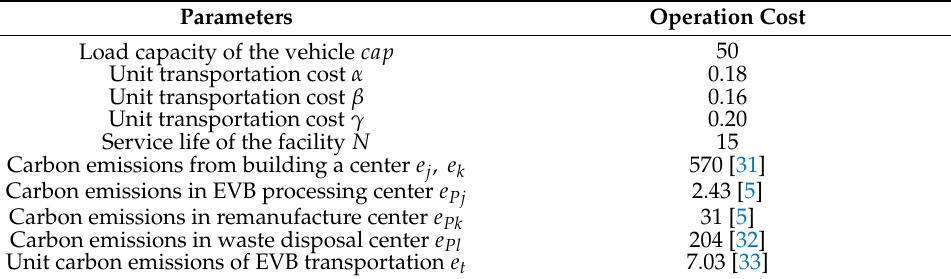
Table 4. Relevant parameters of EVB processing